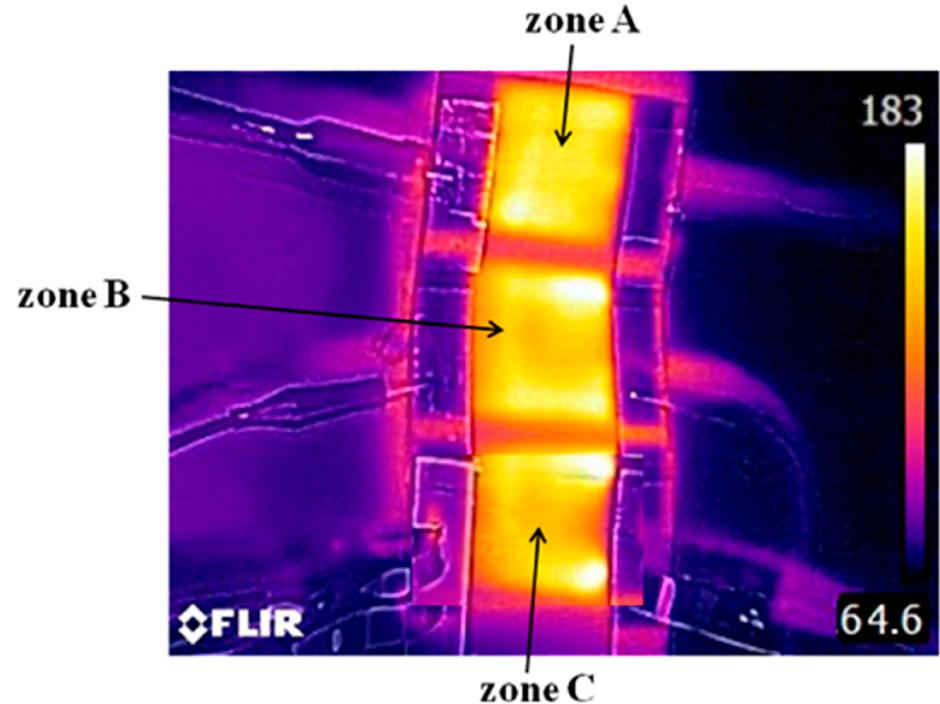
Figure 5. Temperature distribution of the graphene-based heater when an input voltage of 30 V was applied to each zone. (The average steady-state temperature of each zone of the heater was 180 ± 3 °C.).